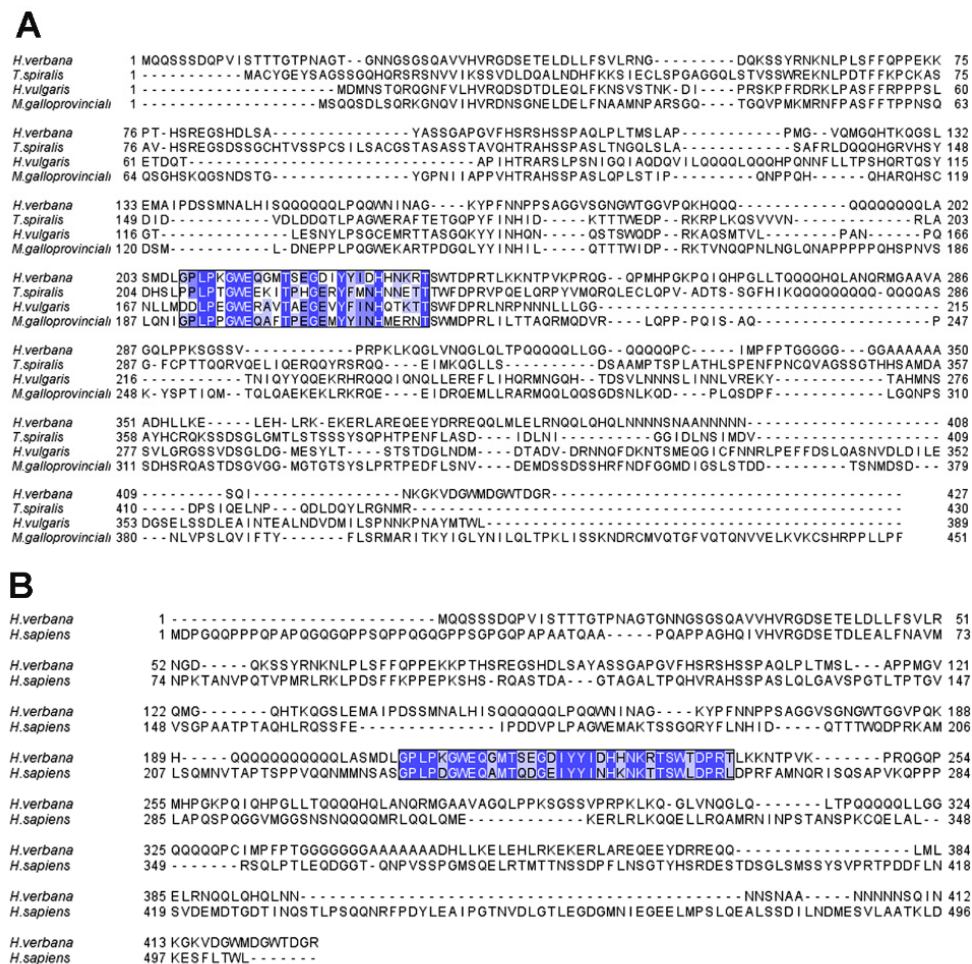
Figure 8. YAP1 conservation analyses. ( A ) The H. verbana YAP1 amino acid sequence, identified in the medicinal leech CNS transcriptome has been aligned with those of H. vulgaris (Cnidaria, CDG70925.1), T. spiralis (Nematoda, KRY35109.1) and M. galloprovincialis (Mollusca, VDI03718.1) obtained from the NCBI database. The YAP1 specific WW domain results are highly conserved and different blue shades indicate the diverse conservation of each amino acid. ( B ) The alignment of H. verbana and H. sapiens YAP1 protein sequences shows the high conservation of the WW domain between these species, validating the correct recognition of the primary antibody used. Accordingly, Western blot analysis showed that a pick of total YAP1 protein expression (i.e., the protein present both in nuclei and cytoplasm) was observed in juvenile leeches, but it turned out to be drastically reduced in adult and recently hatched leeches (Figure 9A). The specific tissue localization of YAP1 was assessed by immunocytochemical staining, showing that in hatched and juvenile leeches YAP1 was preferentially localized in the nucleus (Figure 9D–G), while in adults it was more evident in the cytoplasm of body wall cells (Figure